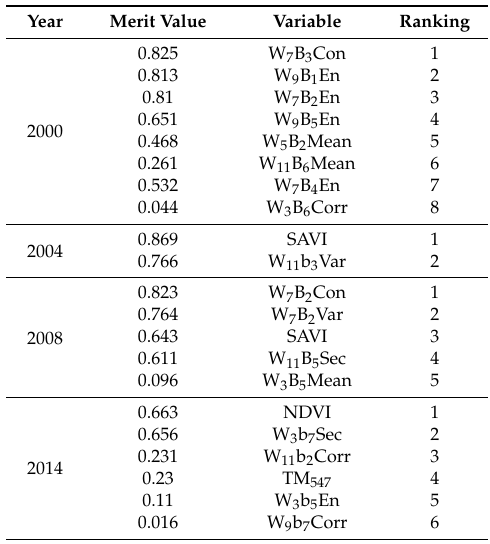
Table 5. The importance of the variables for the AGC estimation in different